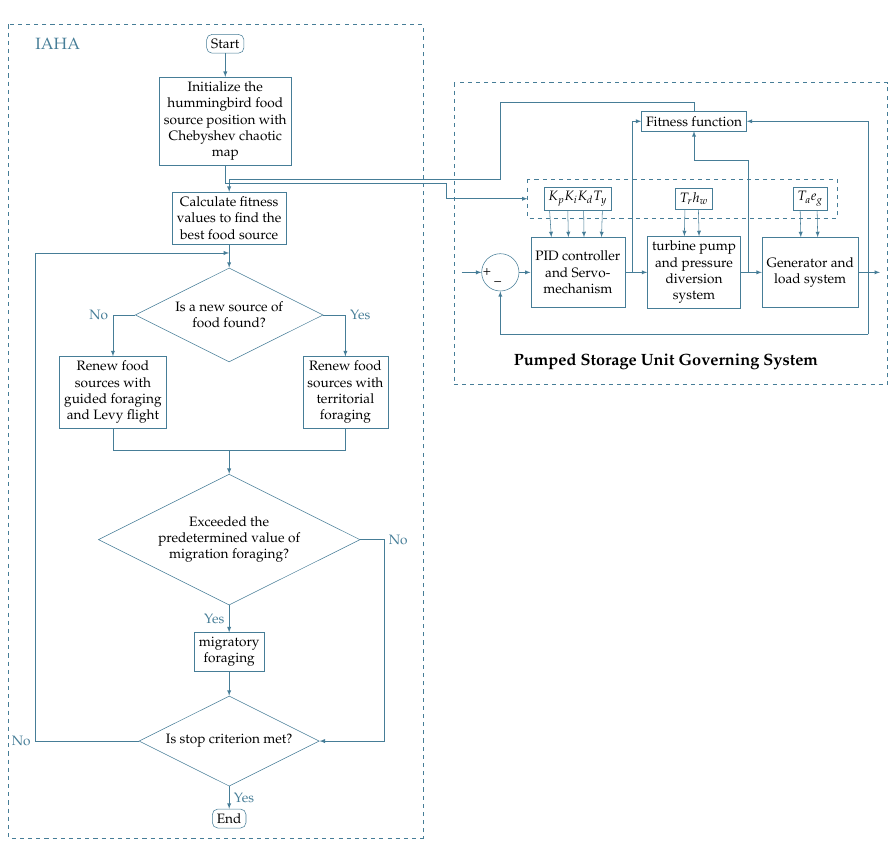
Figure 1. Flowchart of IAHA.